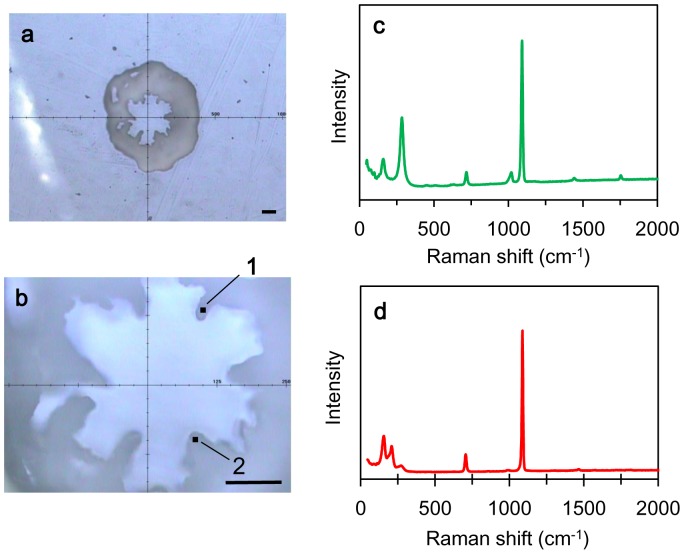
An observation image and Raman shift spectrum of a juvenile skeleton of Acropora tenuis grown in mMg/Ca = 0.5 (#5, Table 1).(a) an observation image of a juvenile formed by the objective lens (×5); (b) an observation image of a juvenile formed by the objective lens (x20); (c) the specific Raman shift of calcite on dot #1 in Figure 1b; (d) the specific Raman shift of aragonite on dot #2 in Figure 1b. Scale bars are 100 µm.